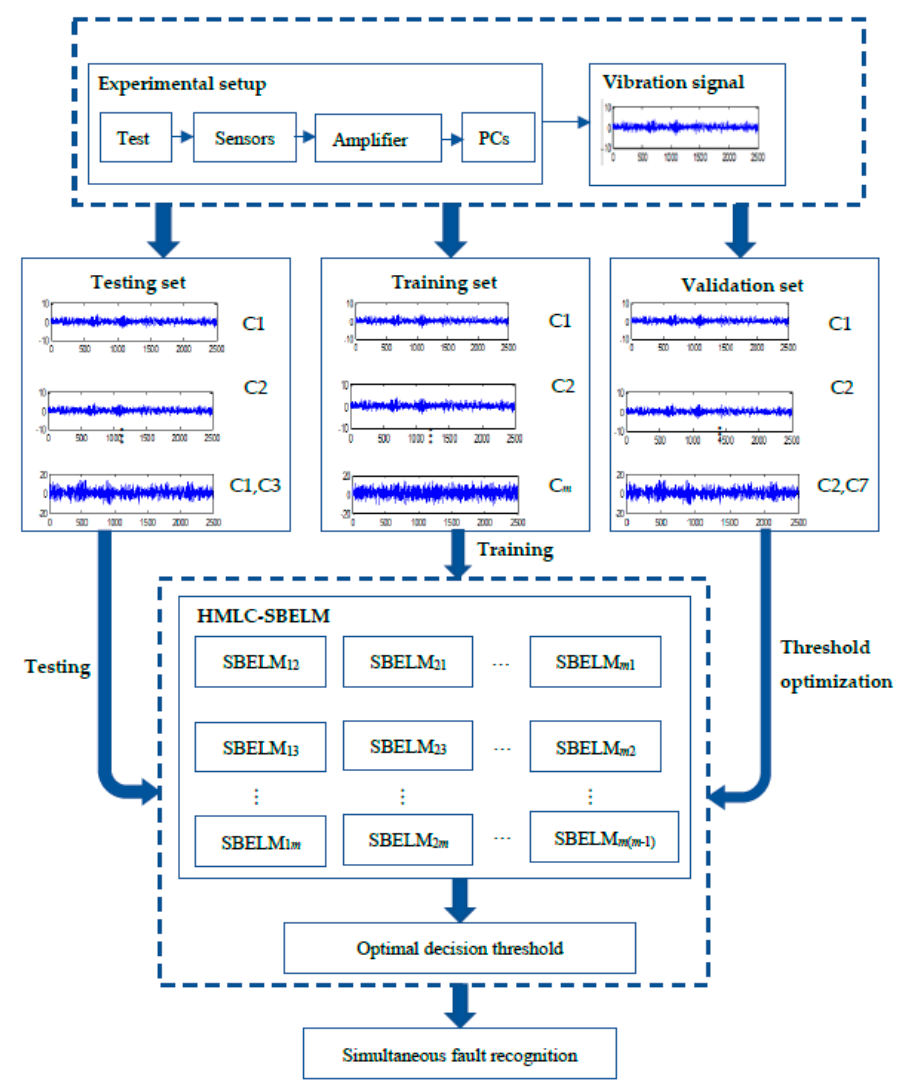
Figure 4. The proposed simultaneous fault diagnostic framework.